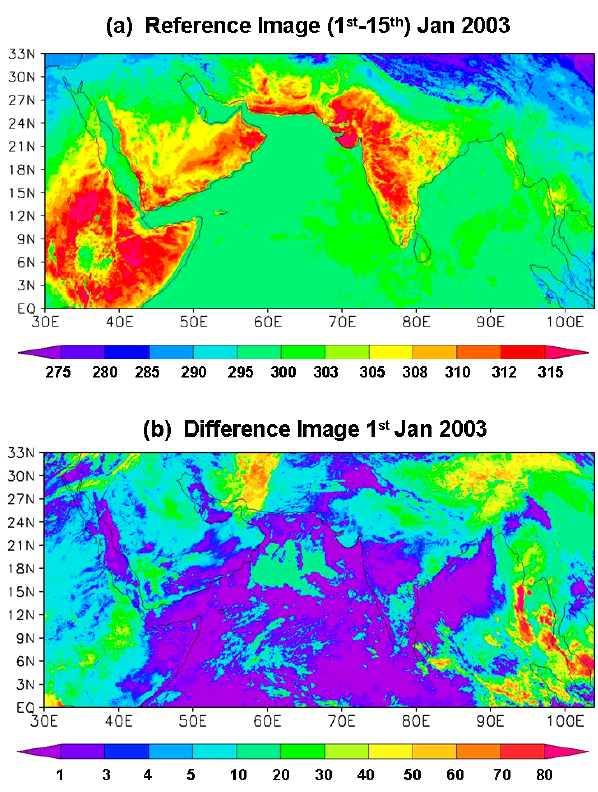
Fig. 1. An example of (a) reference image (1–15 January 2003) and (b) difference image for 1 January